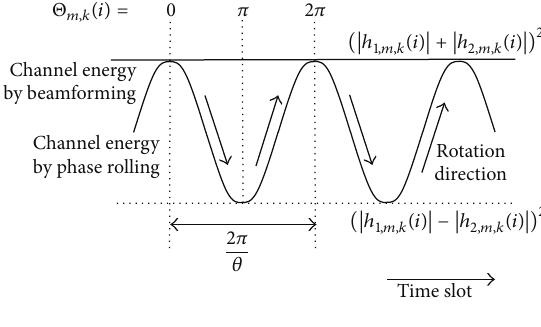
Figure 2: Channel energy by phase